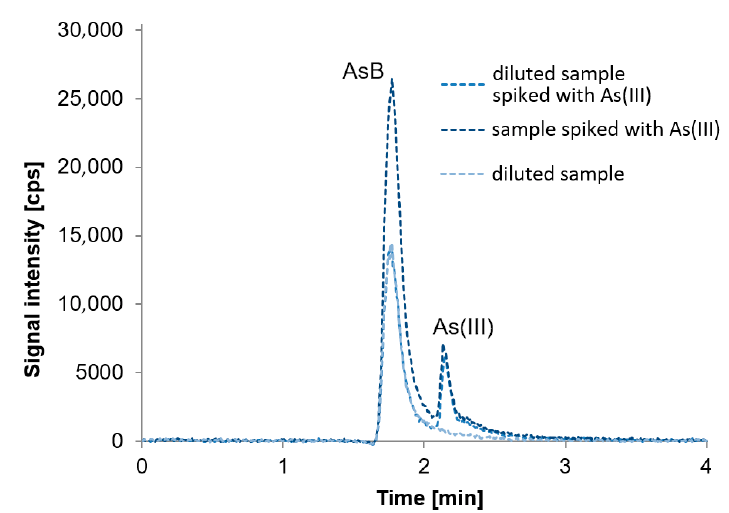
Figure 5. Chromatogram of freshwater fish sample: Undiluted spiked with As(III) with the concentration of 5 µ g L − 1 , twice diluted spiked with As(III) with the concentration of 5 µ g L − 1 , and twice diluted not spiked.